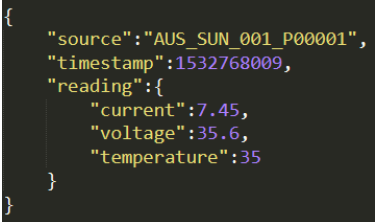
Figure 6. Panel monitoring edge device packet.